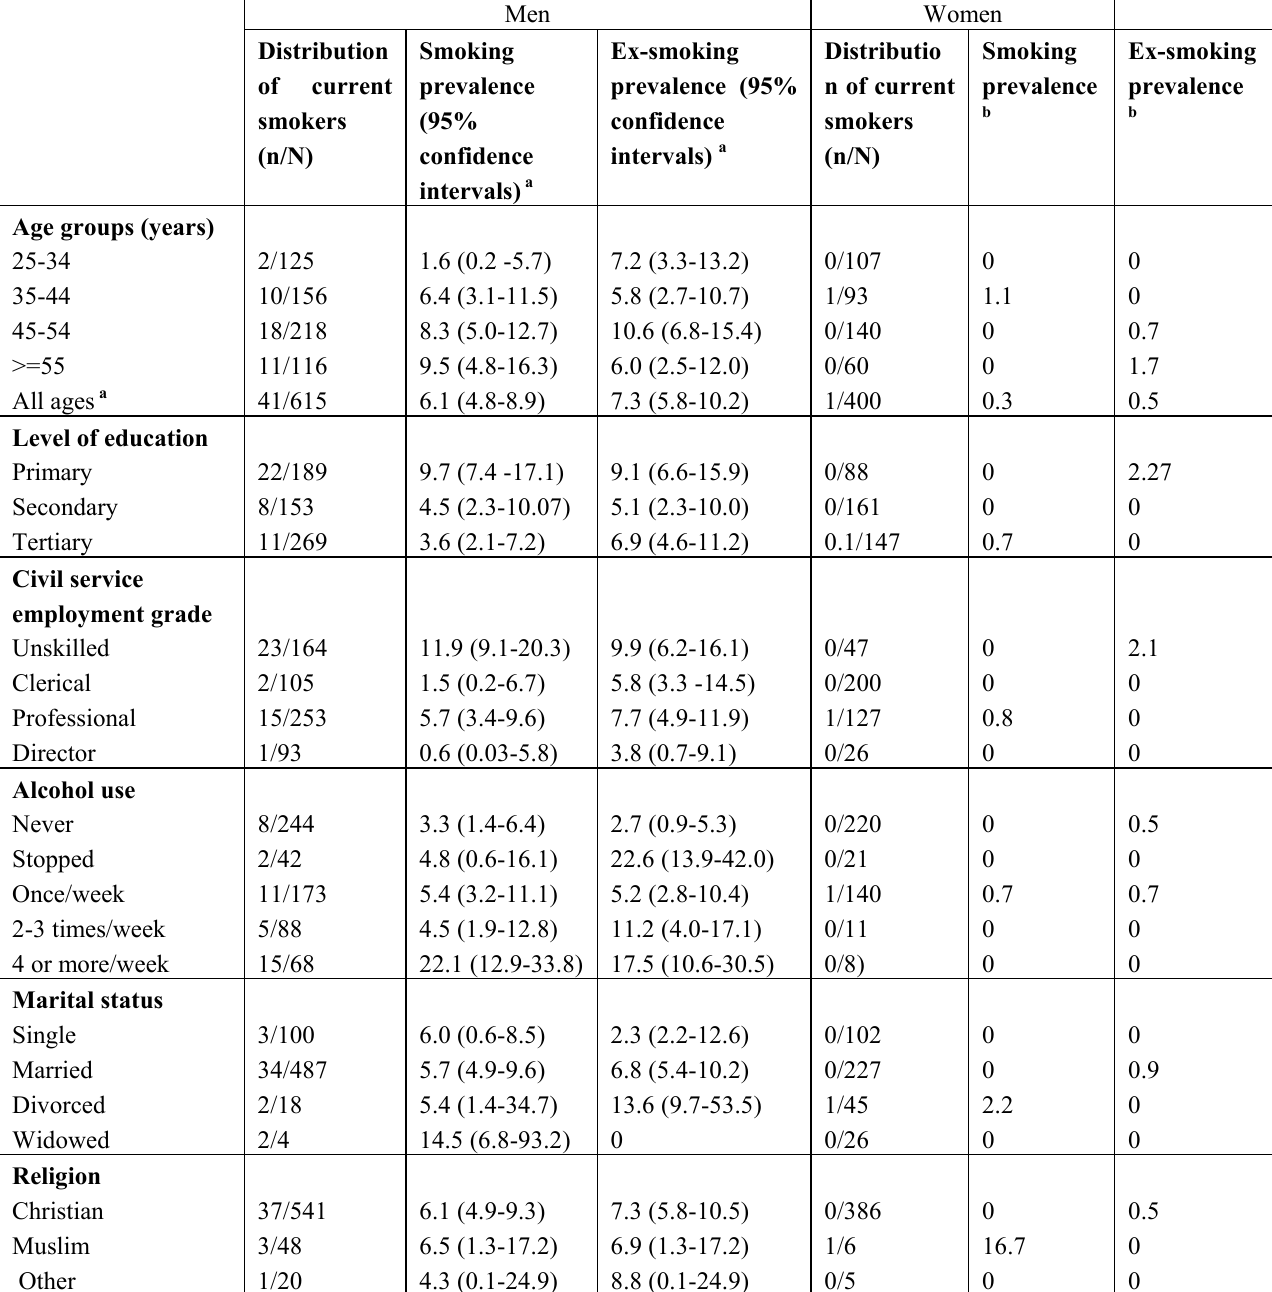
Table 1. Prevalence and distribution of current and ex-smokers in the study